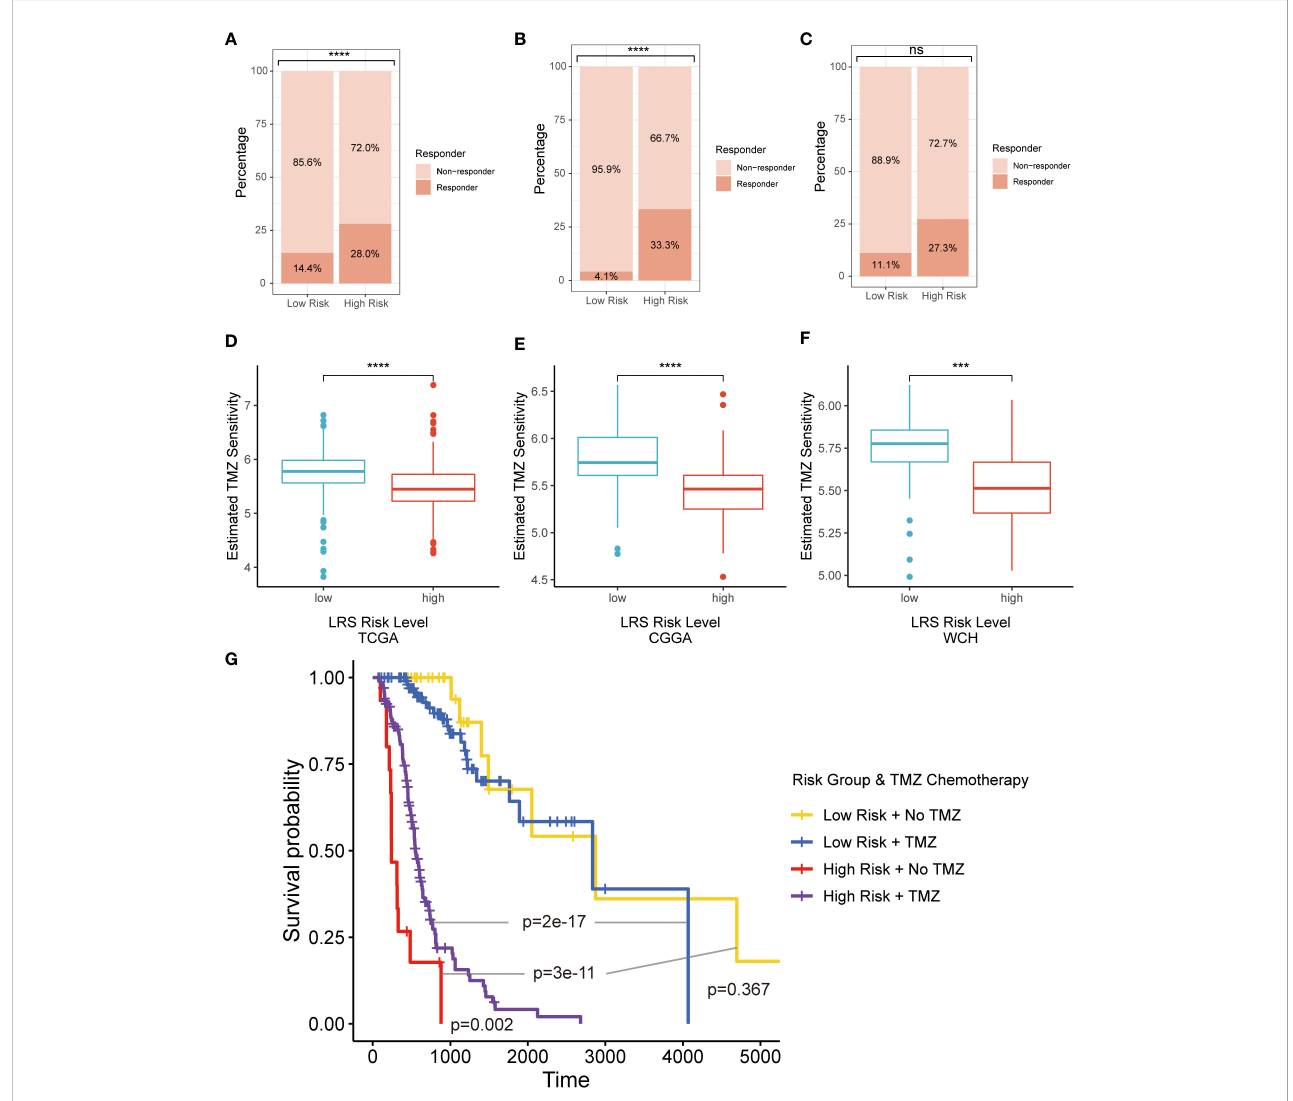
FIGURE 9 Therapeutic response prediction based on LMRG risk group. (A – C) , TIDE algorithm for predicting therapeutic response of ICB for glioma patients in three cohorts; (D – F) , pRRophetic for evaluating the sensitivity of TMZ for glioma treatment in three cohorts; (G) . K-M curves for evaluating prognosis patients in LRS low- and high-risk groups receiving radiotherapy with or without TMZ. LMRG, lipid metabolism-related gene; TIDE, Tumor Immune Dysfunction and Exclusion; ICB, immune checkpoint blocker; K-M, Kaplan-Mier; TMZ, temozolomide. ns, non-signi fi cant. *** p<0.001, **** p<0.0001 in the current